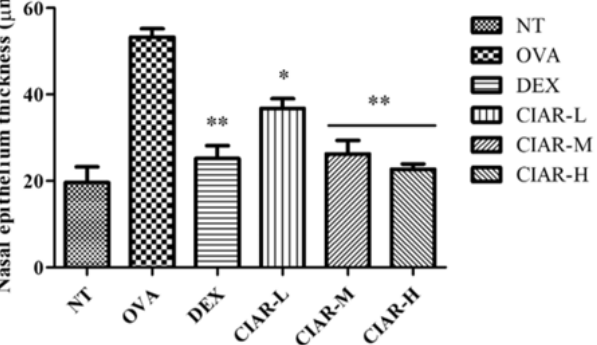
Figure 4. Histopathological changes in the nasal epithelial tissues and thickness. ( A ) Representative images of hematoxylin and eosin-stained sections of the respiratory epithelium. ( B ) Thickness of nasal epithelium. Data are shown as the mean ± SE. Significant differences are indicated as * p < 0.05 and ** p <0.01, compared to the OVA group. NT—normal mice; OVA—OVA-exposed mice; DEX—